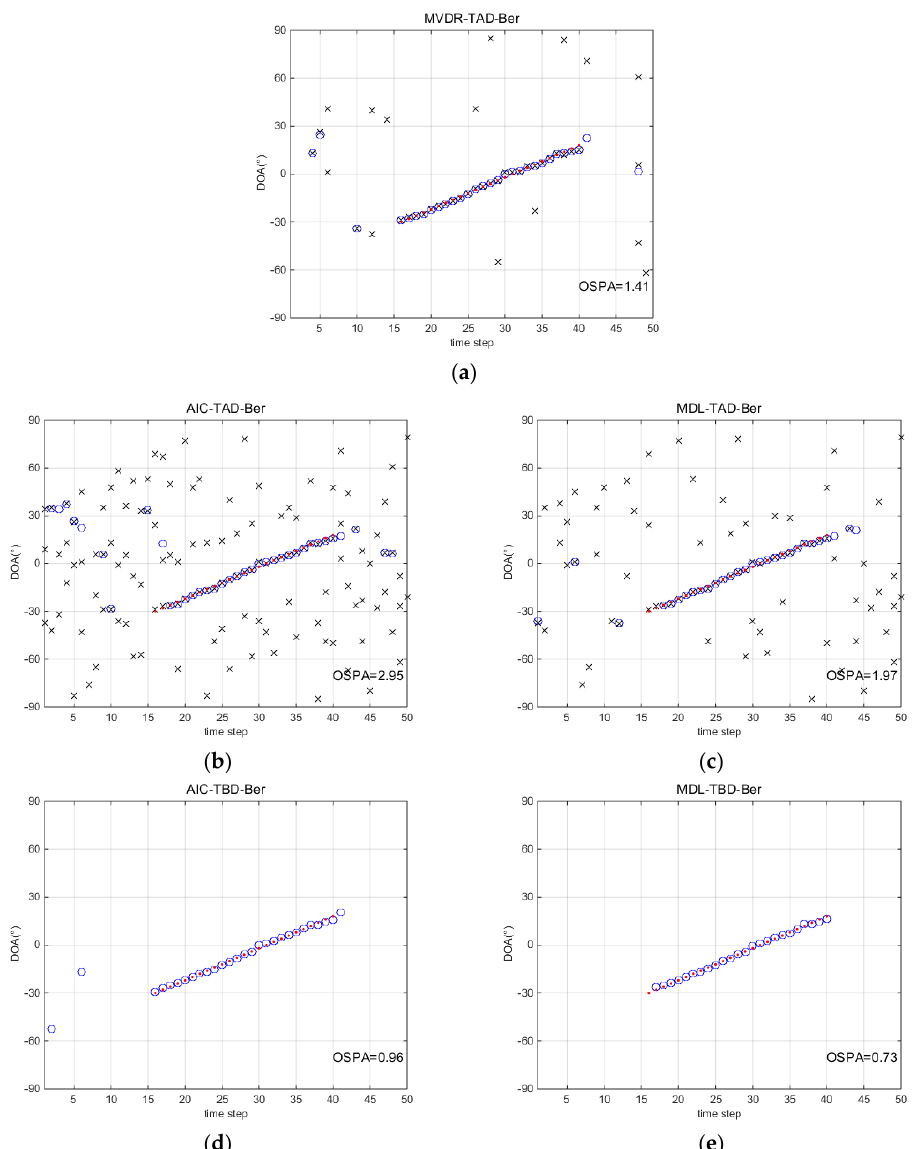
Figure 2. Direction-of-arrival (DOA) tracking results with signal to noise ratio (SNR) = −8 dB and snapshots N = 50. ( a ) minimum-variance-distortionless-response (MVDR)-TAD-Ber; ( b ) AIC-track- after-detect (TAD)-Ber; ( c ) MDL-TAD-Ber; ( d ) AIC-TBD-Ber; ( e ) MDL-TBD-Ber.